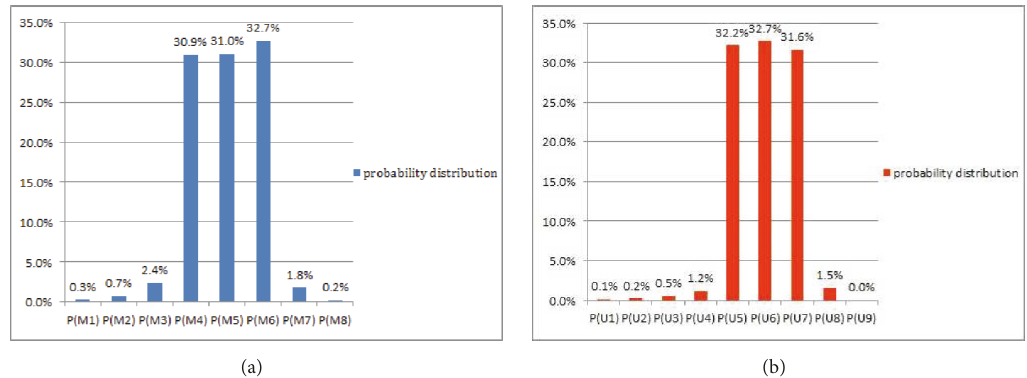
Figure 9: (a) The probability distribution of 𝑚 𝑖 . (b) The probability distribution of 𝑛 𝑖